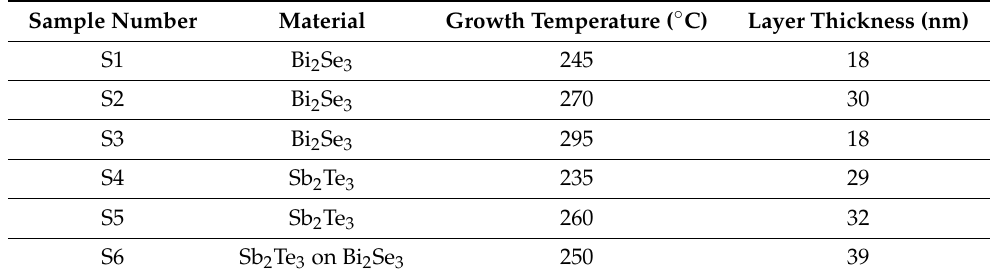
Figure 2. Reflection high-energy electron diffraction (RHEED) images ( a ) after Bi 2 Se 3 growth, ( b ) after Sb 2 Te 3 growth, and ( c ) after the growth of Sb 2 Te 3 /Bi 2 Se 3 stack. RHEED patterns are obtained along [011] direction of the substrate. ( e ) An 18 nm thick Bi 2 Se 3 film (sample S3) with a roughness of Rq = 0.5 nm, ( f ) a 29 nm thick Sb 2 Te 3 film with a roughness of Rq = 2.2 nm (sample S4), and ( d ) a Sb 2 Te 3 /Bi 2 Se 3 stack with a roughness of Rq = 3.8 nm (sample S6). Rq is the root mean square roughness of the surface. Table 1. Samples presented in the study. All samples were grown on virtual In 2 Se 3 /InP(111)B substrates. Sample